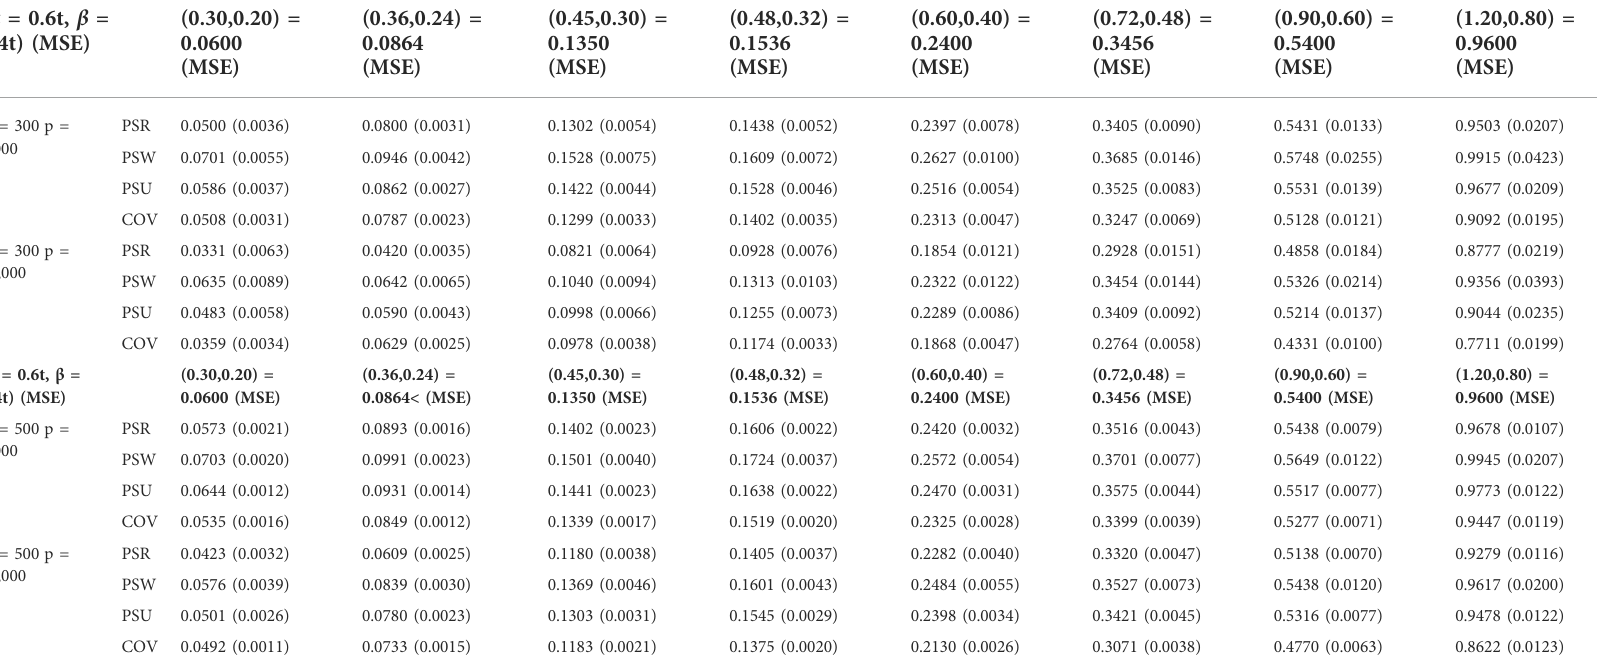
TABLE 3 Estimation results of mediation effects ( αβ ) ( α (cid:1) 0 . 6 t , β (cid:1) 0 . 4 t ). ( α = 0.6t, β = 0.4t)